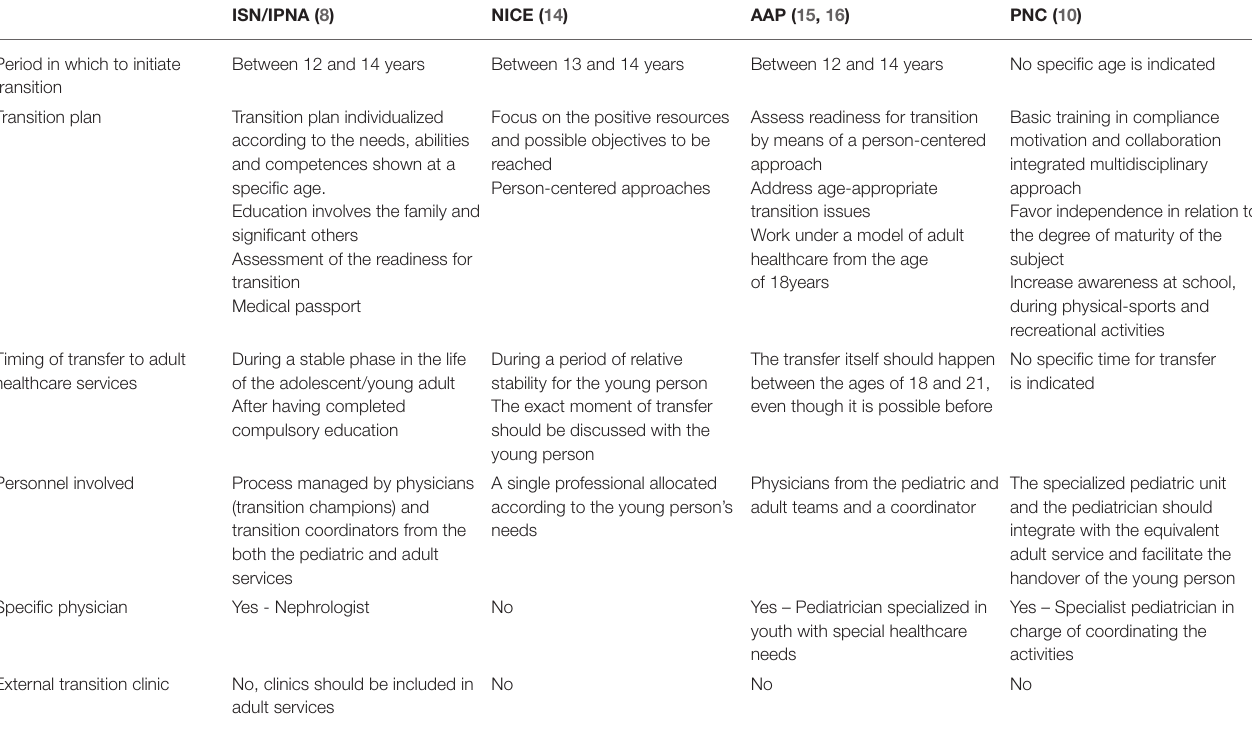
TABLE 1 | Guidelines for the transition from pediatric to adult